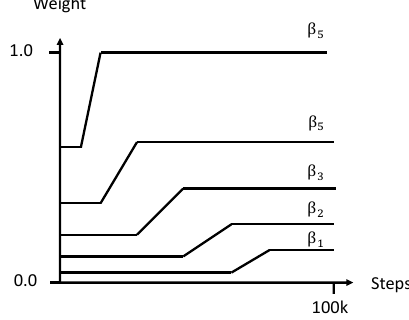
Figure 2. Weight changes of different scales.